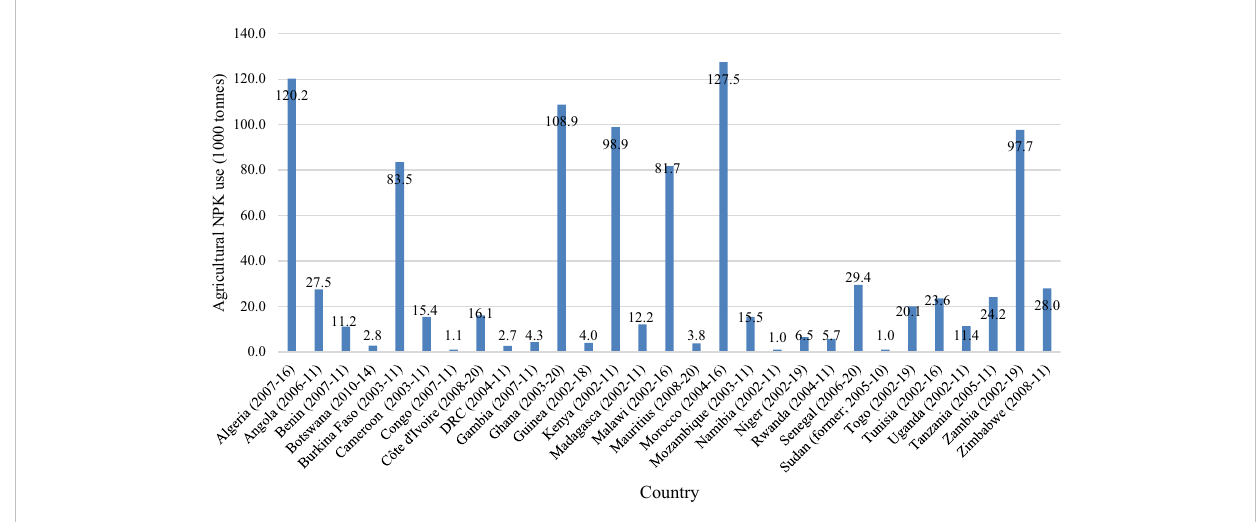
FIGURE 3 Average agricultural use of NPK by African countries. Burundi, Central African Republic, Eritrea, Ethiopia, Gabon, Seychelles, and South Africa had less than 1,000 tons while Nigeria and Egypt had over 200,000 tons, hence, were not included in the graph. Years considered are in parenthesis. Source: FAO database;